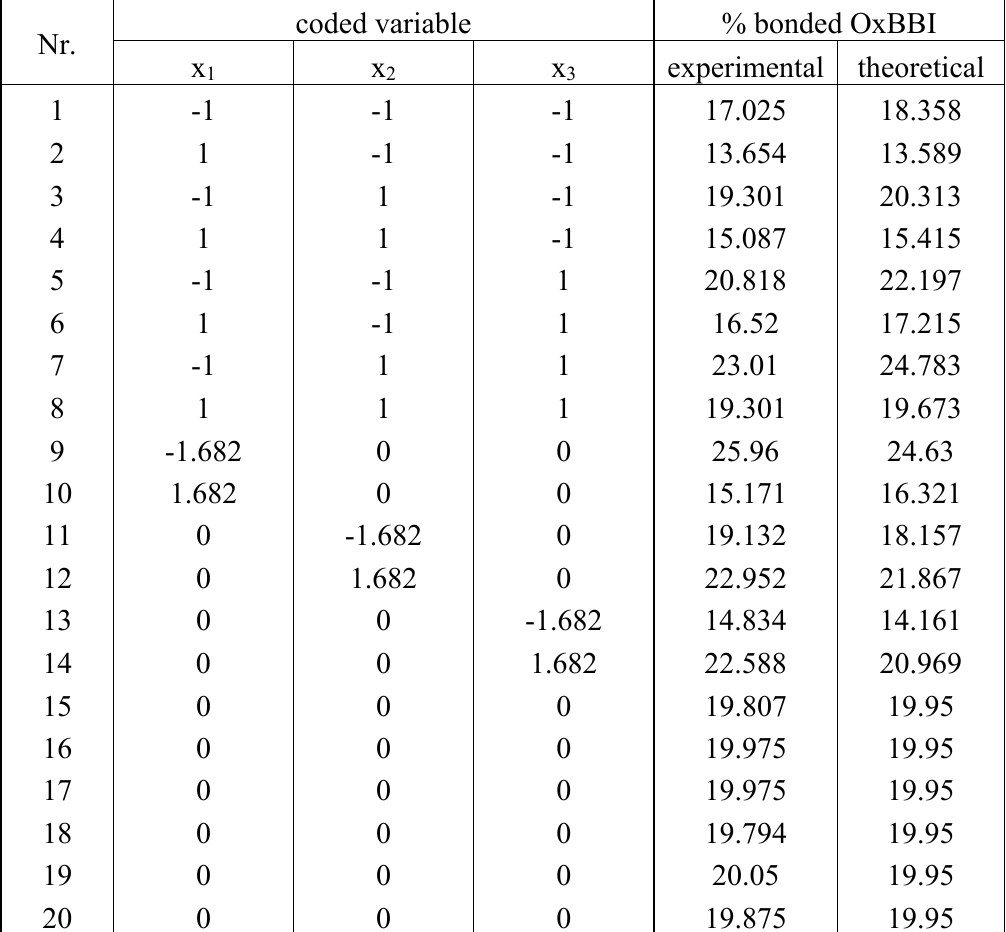
Table 3. Experimental results of the content of coupled